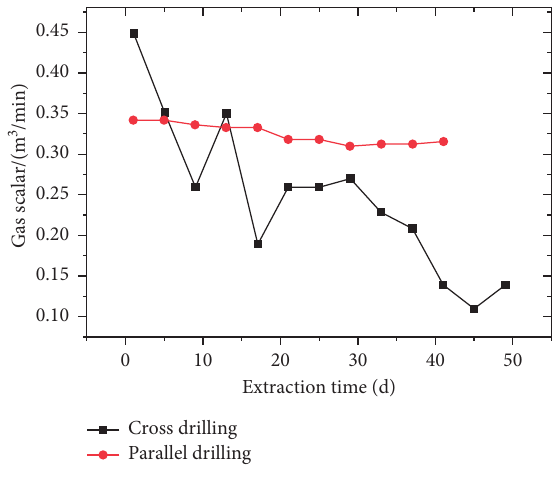
Figure 12: The change of gas